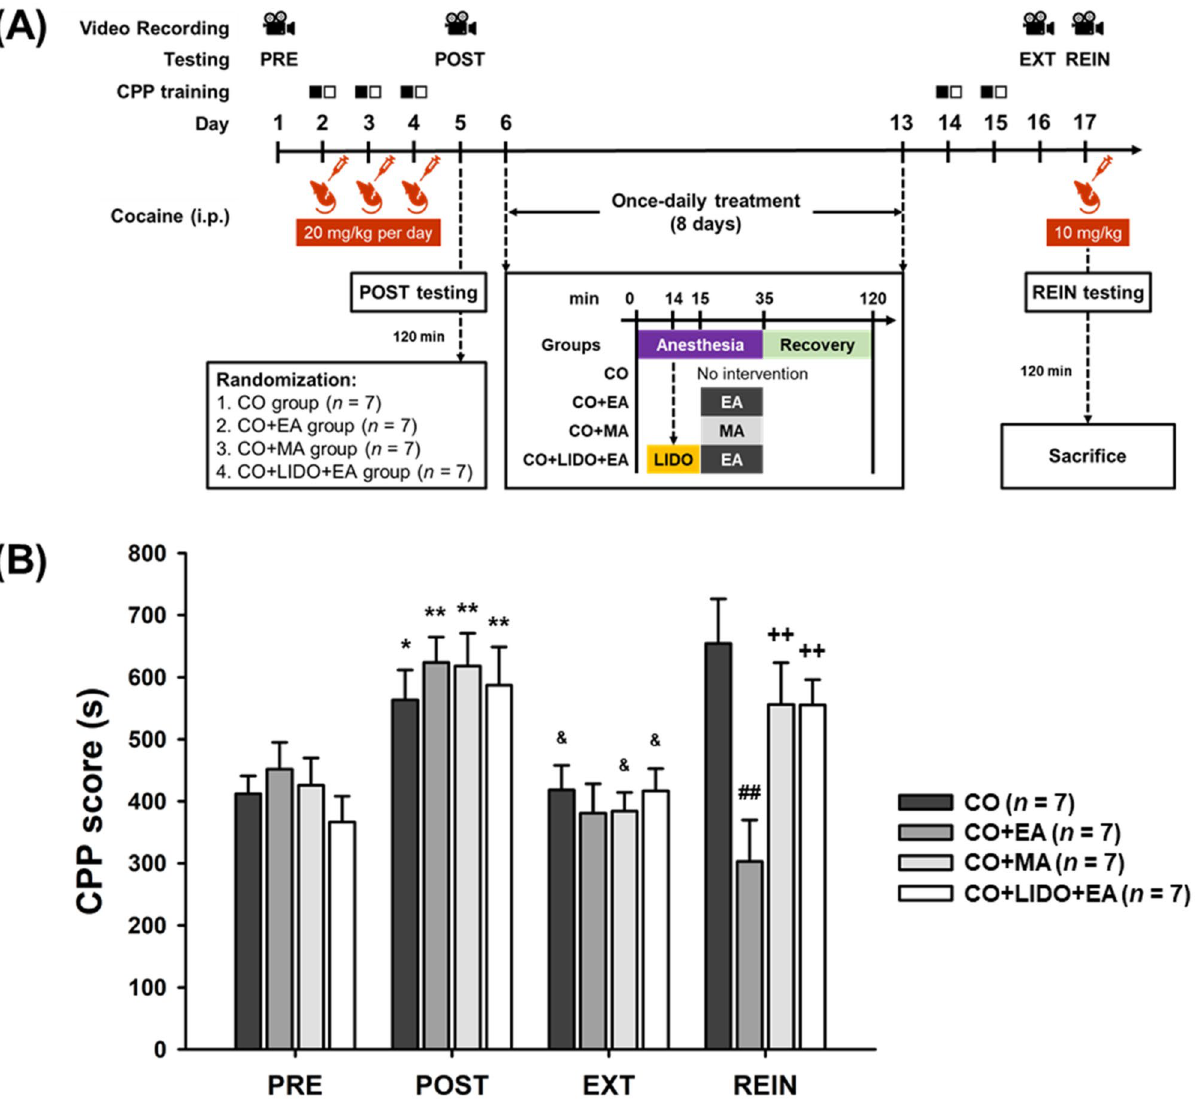
Figure 1. EA at LI4 and LI11 acupoints prevents cocaine-induced CPP reinstatement in mice. ( A ) Timeline for the CPP testing, training, cocaine administration, and experimental interventions. ( B ) CPP scores for the CO group, CO + EA group, CO + MA group, and CO + LIDO + EA group, obtained during PRE, POST, EXT, and REIN testing. All data are expressed as the means ± S.E.M. ( n = 7 mice per group). * p < 0.05; ** p < 0.01 versus the PRE phases; & p < 0.05 versus the REIN phases; ## p < 0.01 versus the CO group; ++ p < 0.01 versus the EA group (two-way ANOVA with the LSD post-hoc test). Abbreviations: CPP = Cocaine-induced conditioned place preference; PRE = Preconditioning testing; POST = Post-conditioning testing; EXT = Extinction of cocaine CPP testing; REIN = Cocaine-primed reinstatement testing; CO = No intervention; CO + EA = EA treatment; CO + MA = MA treatment; CO + LIDO + EA = Lidocaine (2%, 10 μL) injection followed by EA